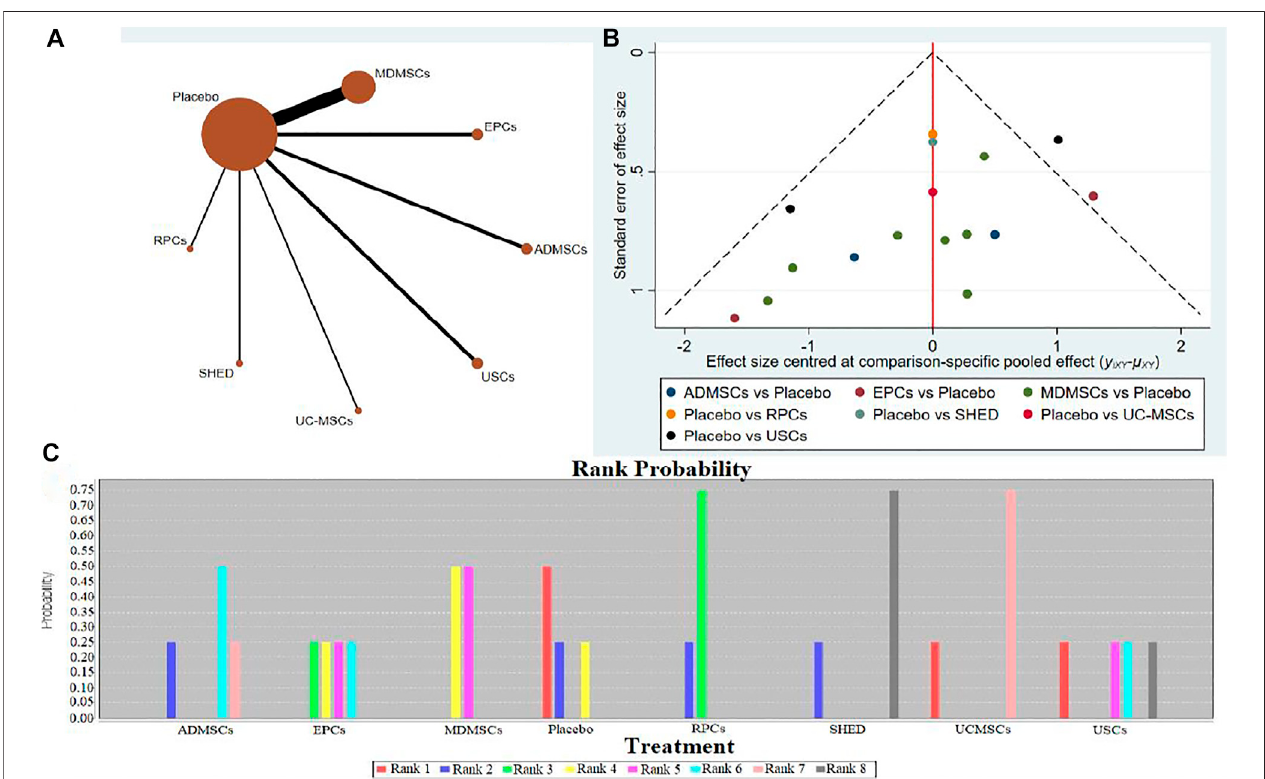
FIGURE7| NetworkMeta-analysisofblood ureanitrogenlevelat7 daysafter administration (A) Evidencenetworkdiagram; (B) Thecomparison-correctionfunnel plot; (C) The ranking results).